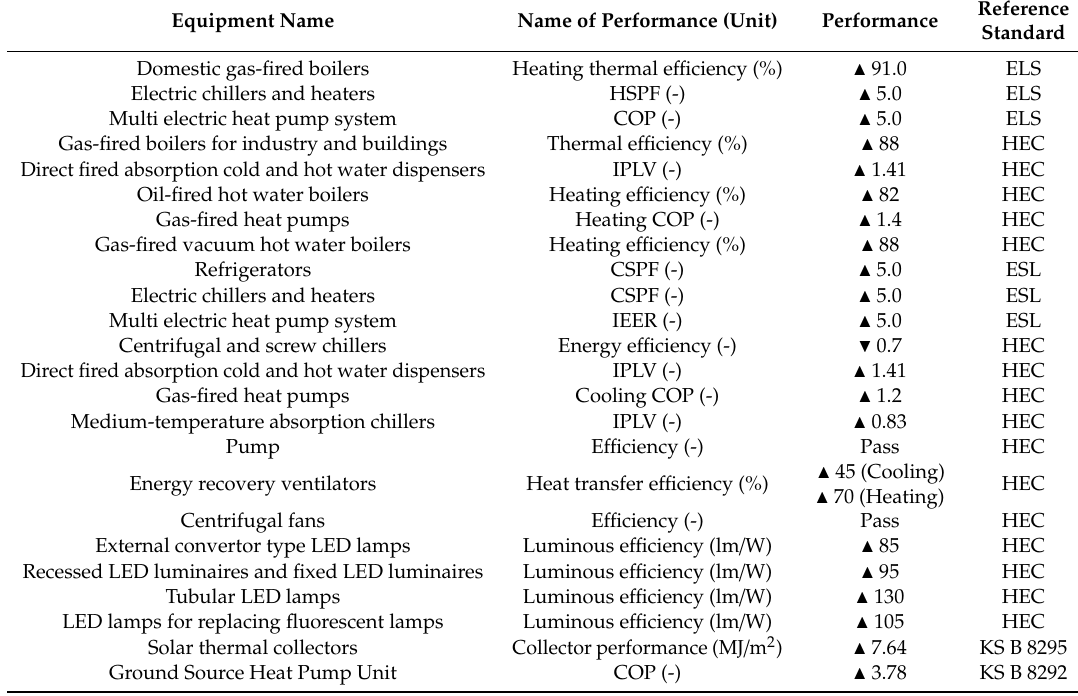
Table 7. Test methods and performance reference of the